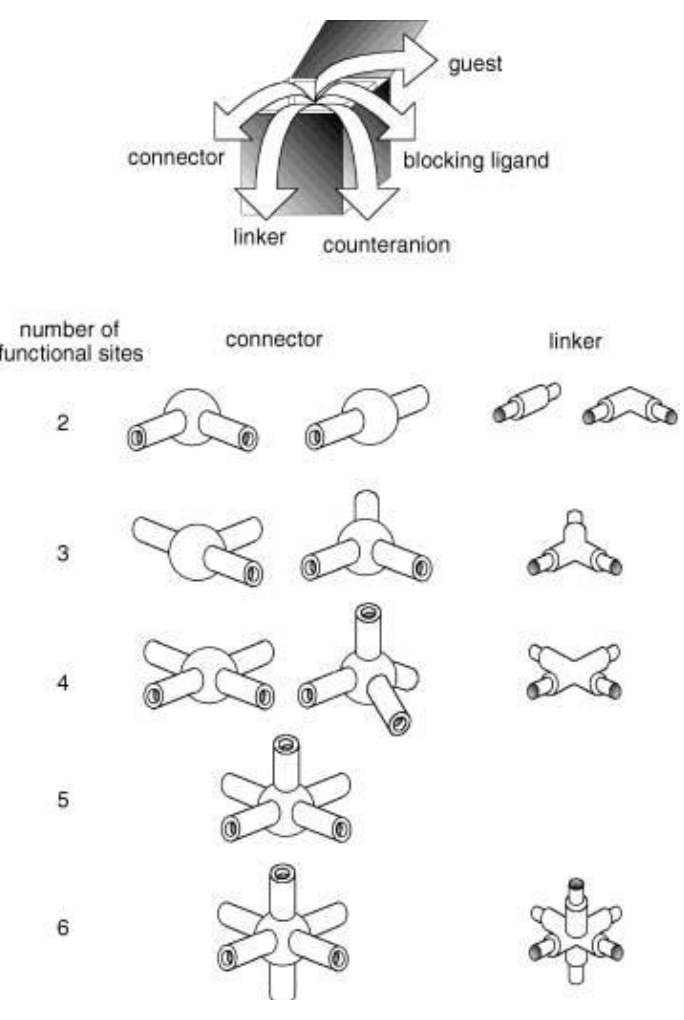
Figure 2. The illustration dynamic behaviors of the metal-organic frameworks’ (MOFs) structure upon interacting with guest molecules. ( a ) 2-dimension; ( b ) 1-dimension; ( c ) 3 dimension. Red spheres stand for the metals; lines stand for the organic linkers. Reprinted with permission from [11]. Copyright 2013 American Chemical